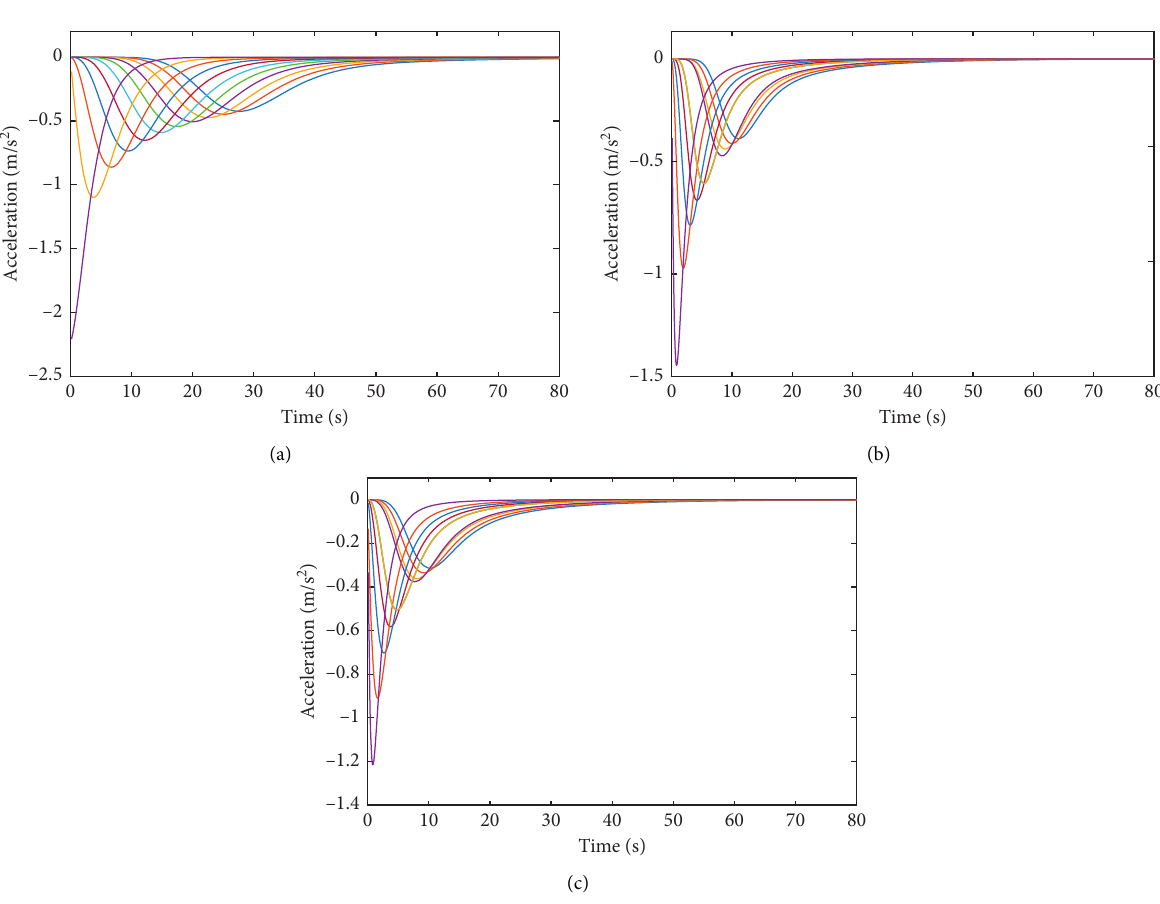
Figure 8: Acceleration evolution of eleven vehicles during the arrival process simulated by (a) FVD model, (b) AFVD model, and (c) AAFVD model.